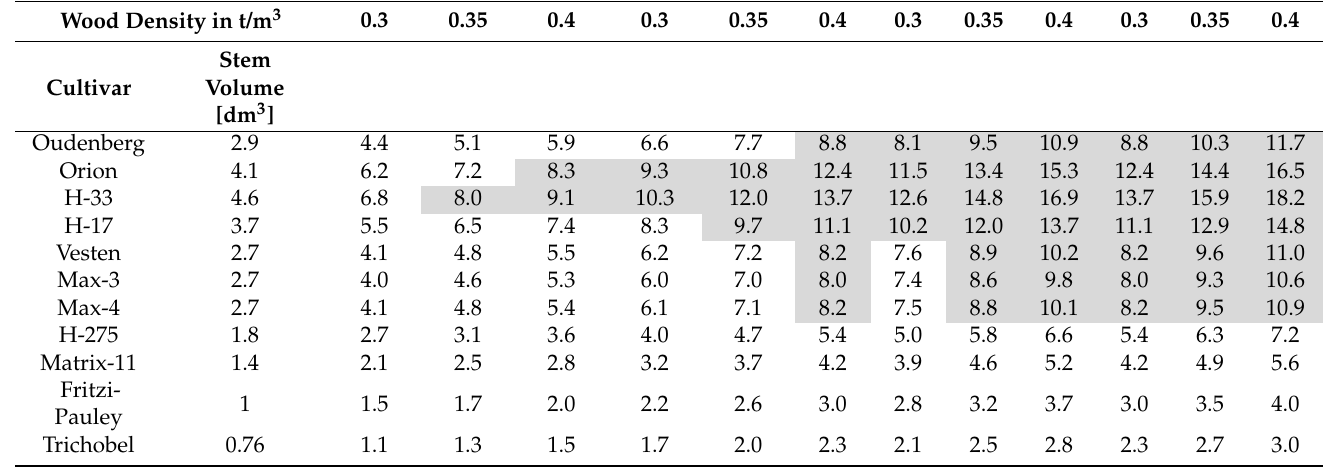
(Table S5). By end of the second season, the average stem volume of Max-3 (2 dm 3 ), which was lower, but still the same range, than the corresponding stem volumes of Max-3 in 1.4 dm 3 , which was only about two thirds of the corresponding stem volume of H-11 in Almaty at the end of the second season (Table 8 and Table